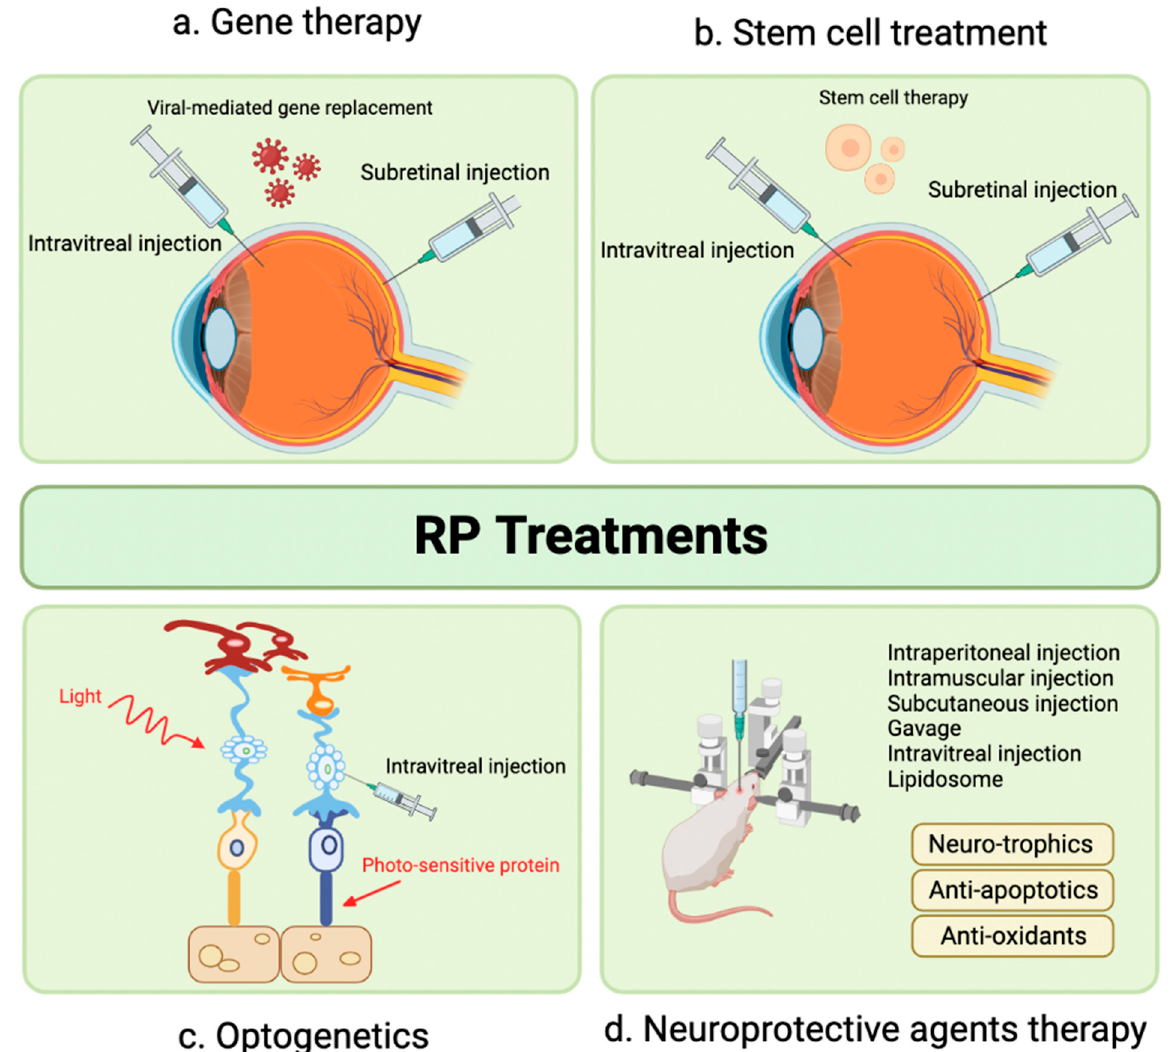
Figure 1. Advanced therapeutic modalities for retinitis pigmentosa. ( a ) Gene therapy, using virus- mediated injection of therapeutic gene to replace disease-causing gene; ( b ) Cell therapy, by injecting stem cells to replace injured cells and form synaptic connections with remaining retinal neurons; ( c ) Optogenetics, by introducing photosensitive proteins into degenerated retina to restore cone function, and ( d ) Neuroprotective agents, such as neurotrophic factors, anti-apoptotic agents and antioxidants, used in early stages of the disease and as adjunctive treatment. Adapted by BioRender.com (2023). Retrieved from https://app.biorender.com/biorender-templates (accessed on 20 January